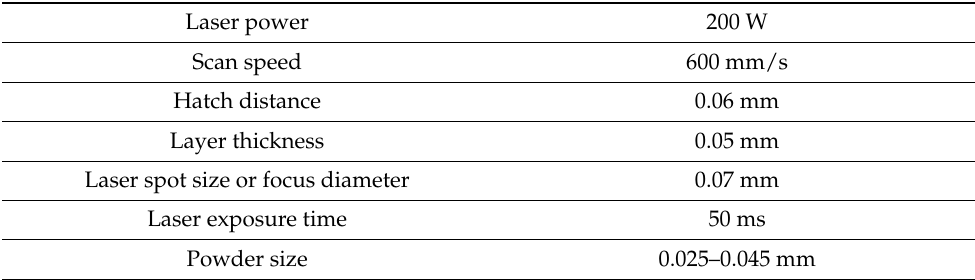
Table 2. Printing parameters used in the selective laser melting process.